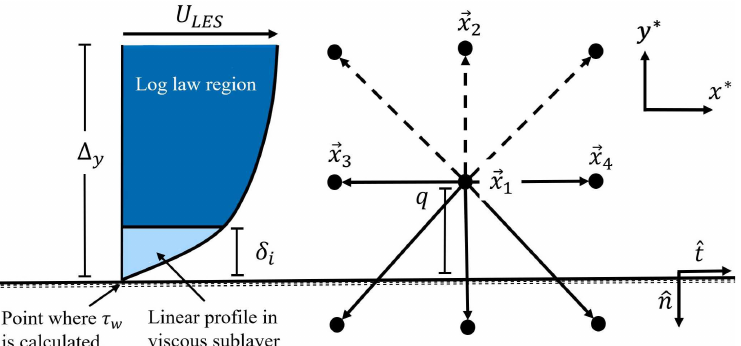
Figure 2. Sketch of LBM/pLBM node DF ((—–) known, and (- - - -) missing) reconstruction and typical boundary layer (BL) profile e.g., [35] near a solid boundary/wall (here assumed to be 2D for simplicity). The wall parallel coordinate system is defined as ( x ∗ , y ∗ ), based on unit normal and tangential vectors to the wall (ˆ n , ˆ t ). In this sketch, U LES = ˜ u 2 and (cid:126) x i = x i , as used in the